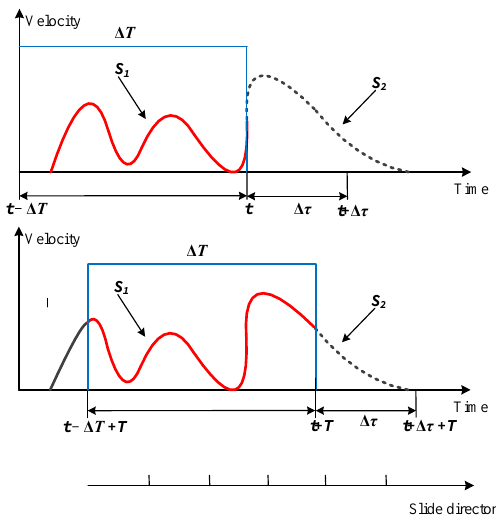
Figure 14. Principle of the slide time window.